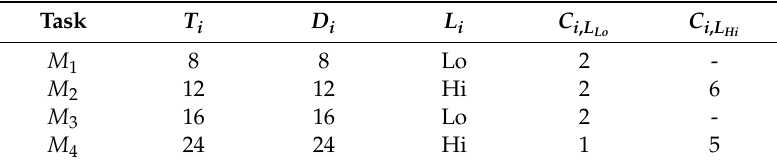
Table 2. Four-task set example.